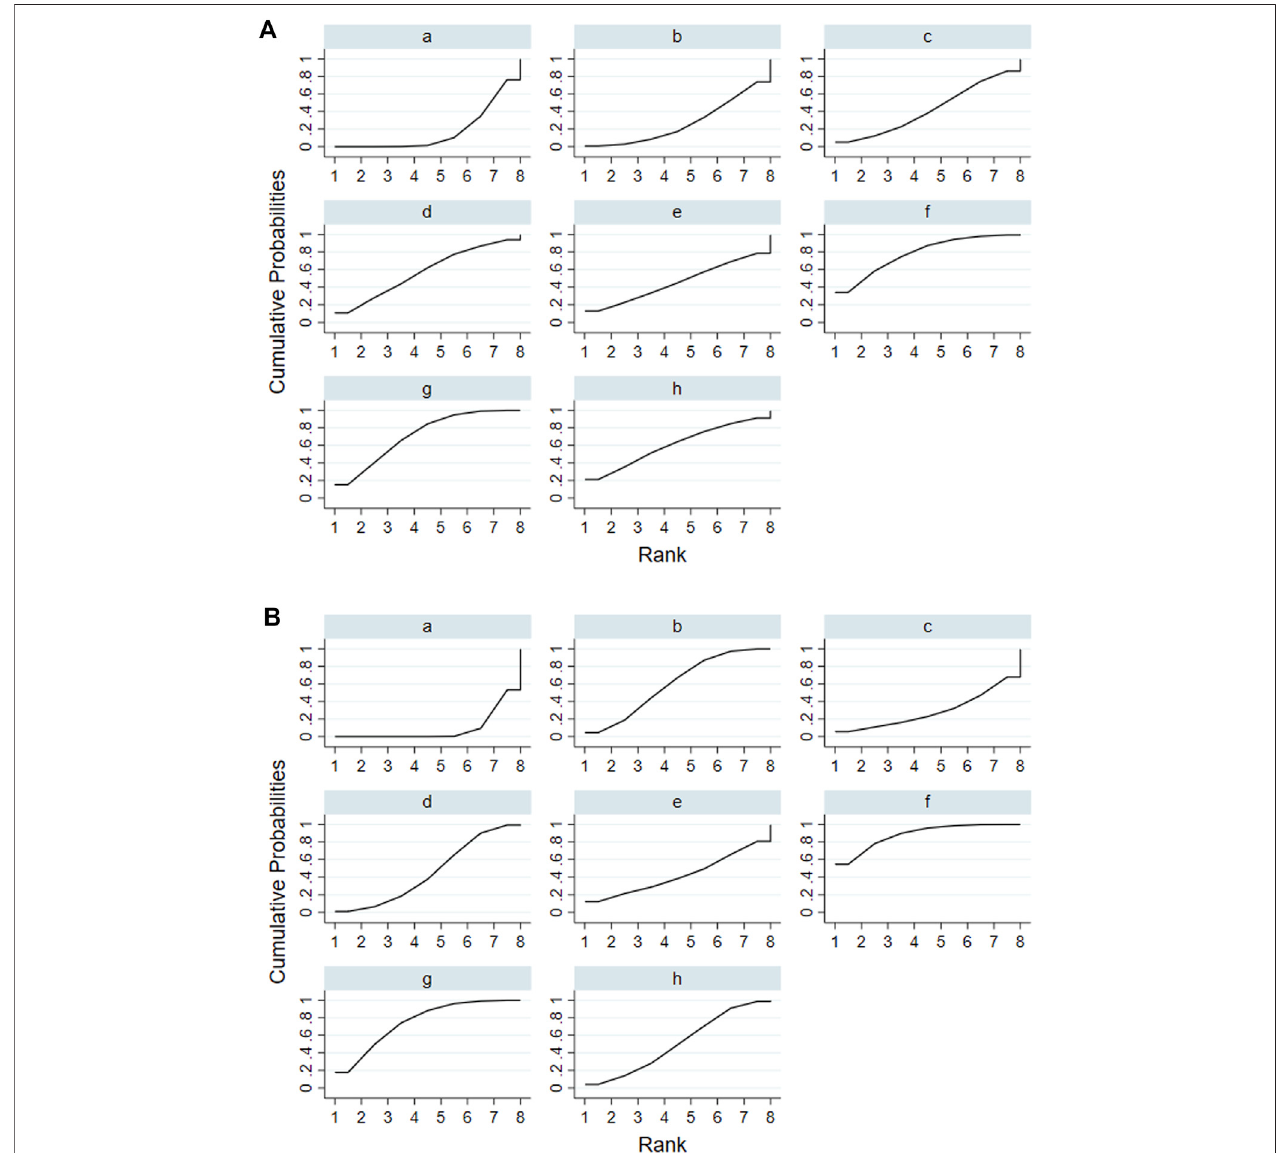
FIGURE 5 | Surface under the cumulative ranking curve (SUCRA) of pruritus score and TBA. Notes: (i): UDCA, (ii): Yinzhihuang oral liquid + UDCA, (iii): salvia injection + UDCA, (iv): Yinchenhao decoction + UDCA, (v): the similar prescription of Yinchenhao decoction 1 + UDCA, (vi): the similar prescription of Yinchenhao decoction 2 + UDCA, (vii): the similar prescription of Yinchenhao decoction 3 + UDCA, and (viii): other traditional Chinese medicine prescriptions + UDCA. (A) Pruritus score. (B)